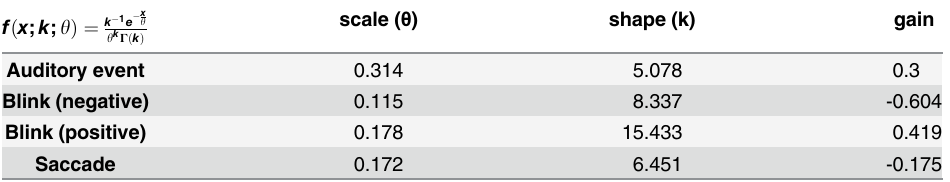
Table 1. Parameters of gamma distributions for separate response profiles.